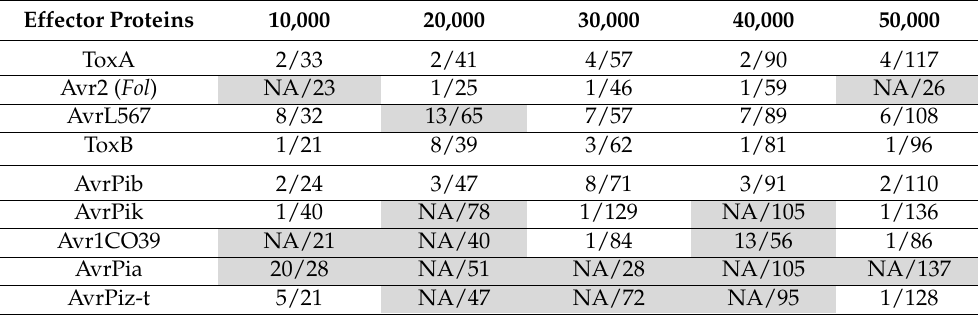
Table 3. Summary of clustering of the best structural models for ToxA-like and MAX effectors using the MaxCluster nearest neighbour method for different nstruct values. The table provides the rank of the cluster that includes the best model and the total number of clusters. Effectors will have different best models for each nstruct value. Clustering was performed on the 10% best REU. Grey colour is used to highlight clusters that included the best model but were ranked outside of the top 10 largest clusters or where the best model was not within the 10% best REU and thus was not included in the clustering step